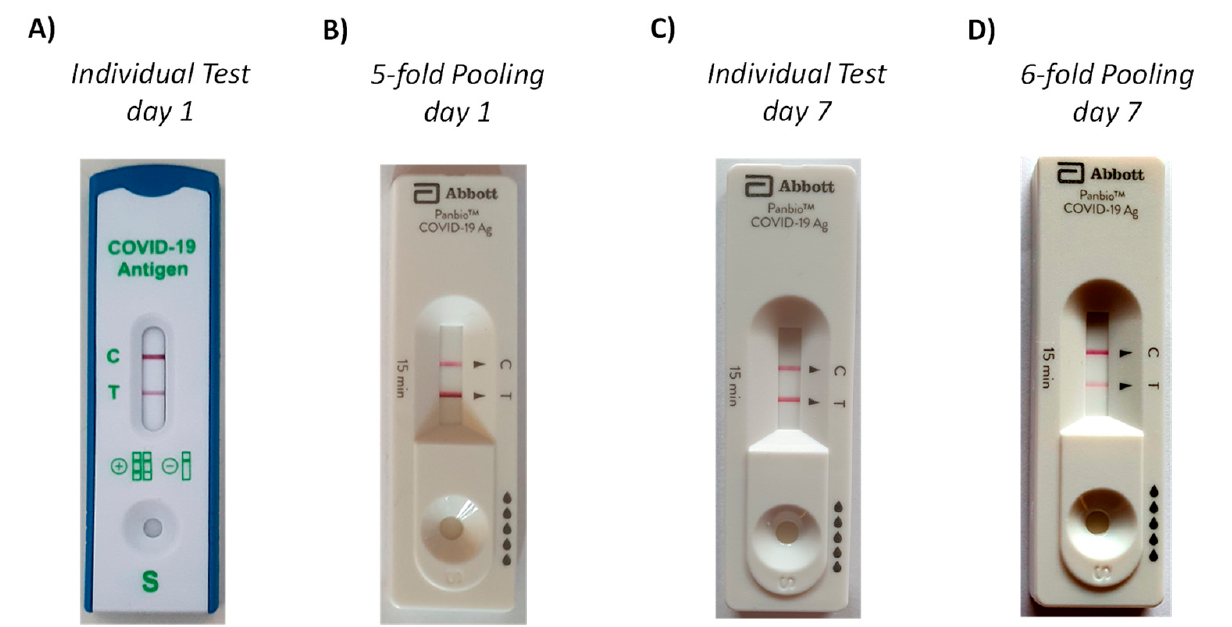
Figure 7. Photographs from case study involving a patient with PCR-confirmed COVID-19: images of test cassettes after individual or pooled tests with one swab from the patient and four or five swabs from a healthy volunteer among the authors at the time point after onset of symptoms given. ( A ) Individual test with Lyher Covid-19 Antigen Rapid test at noon on the day of onset of symptoms, ( B ) pooled assay with Abbott test five hours after the individual test, ( C ) individual test with Panbio Abbott system after one week, ( D ) six-fold pooling test after one week, immediately after the individual test.